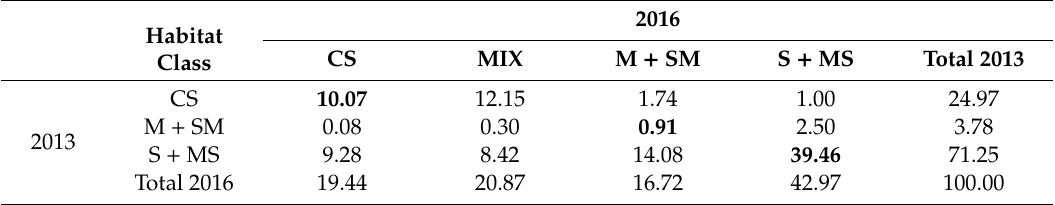
Table 4. Change detection transition matrix of habitat classes in Chioggia 2013 and 2016 AOIs. Bold